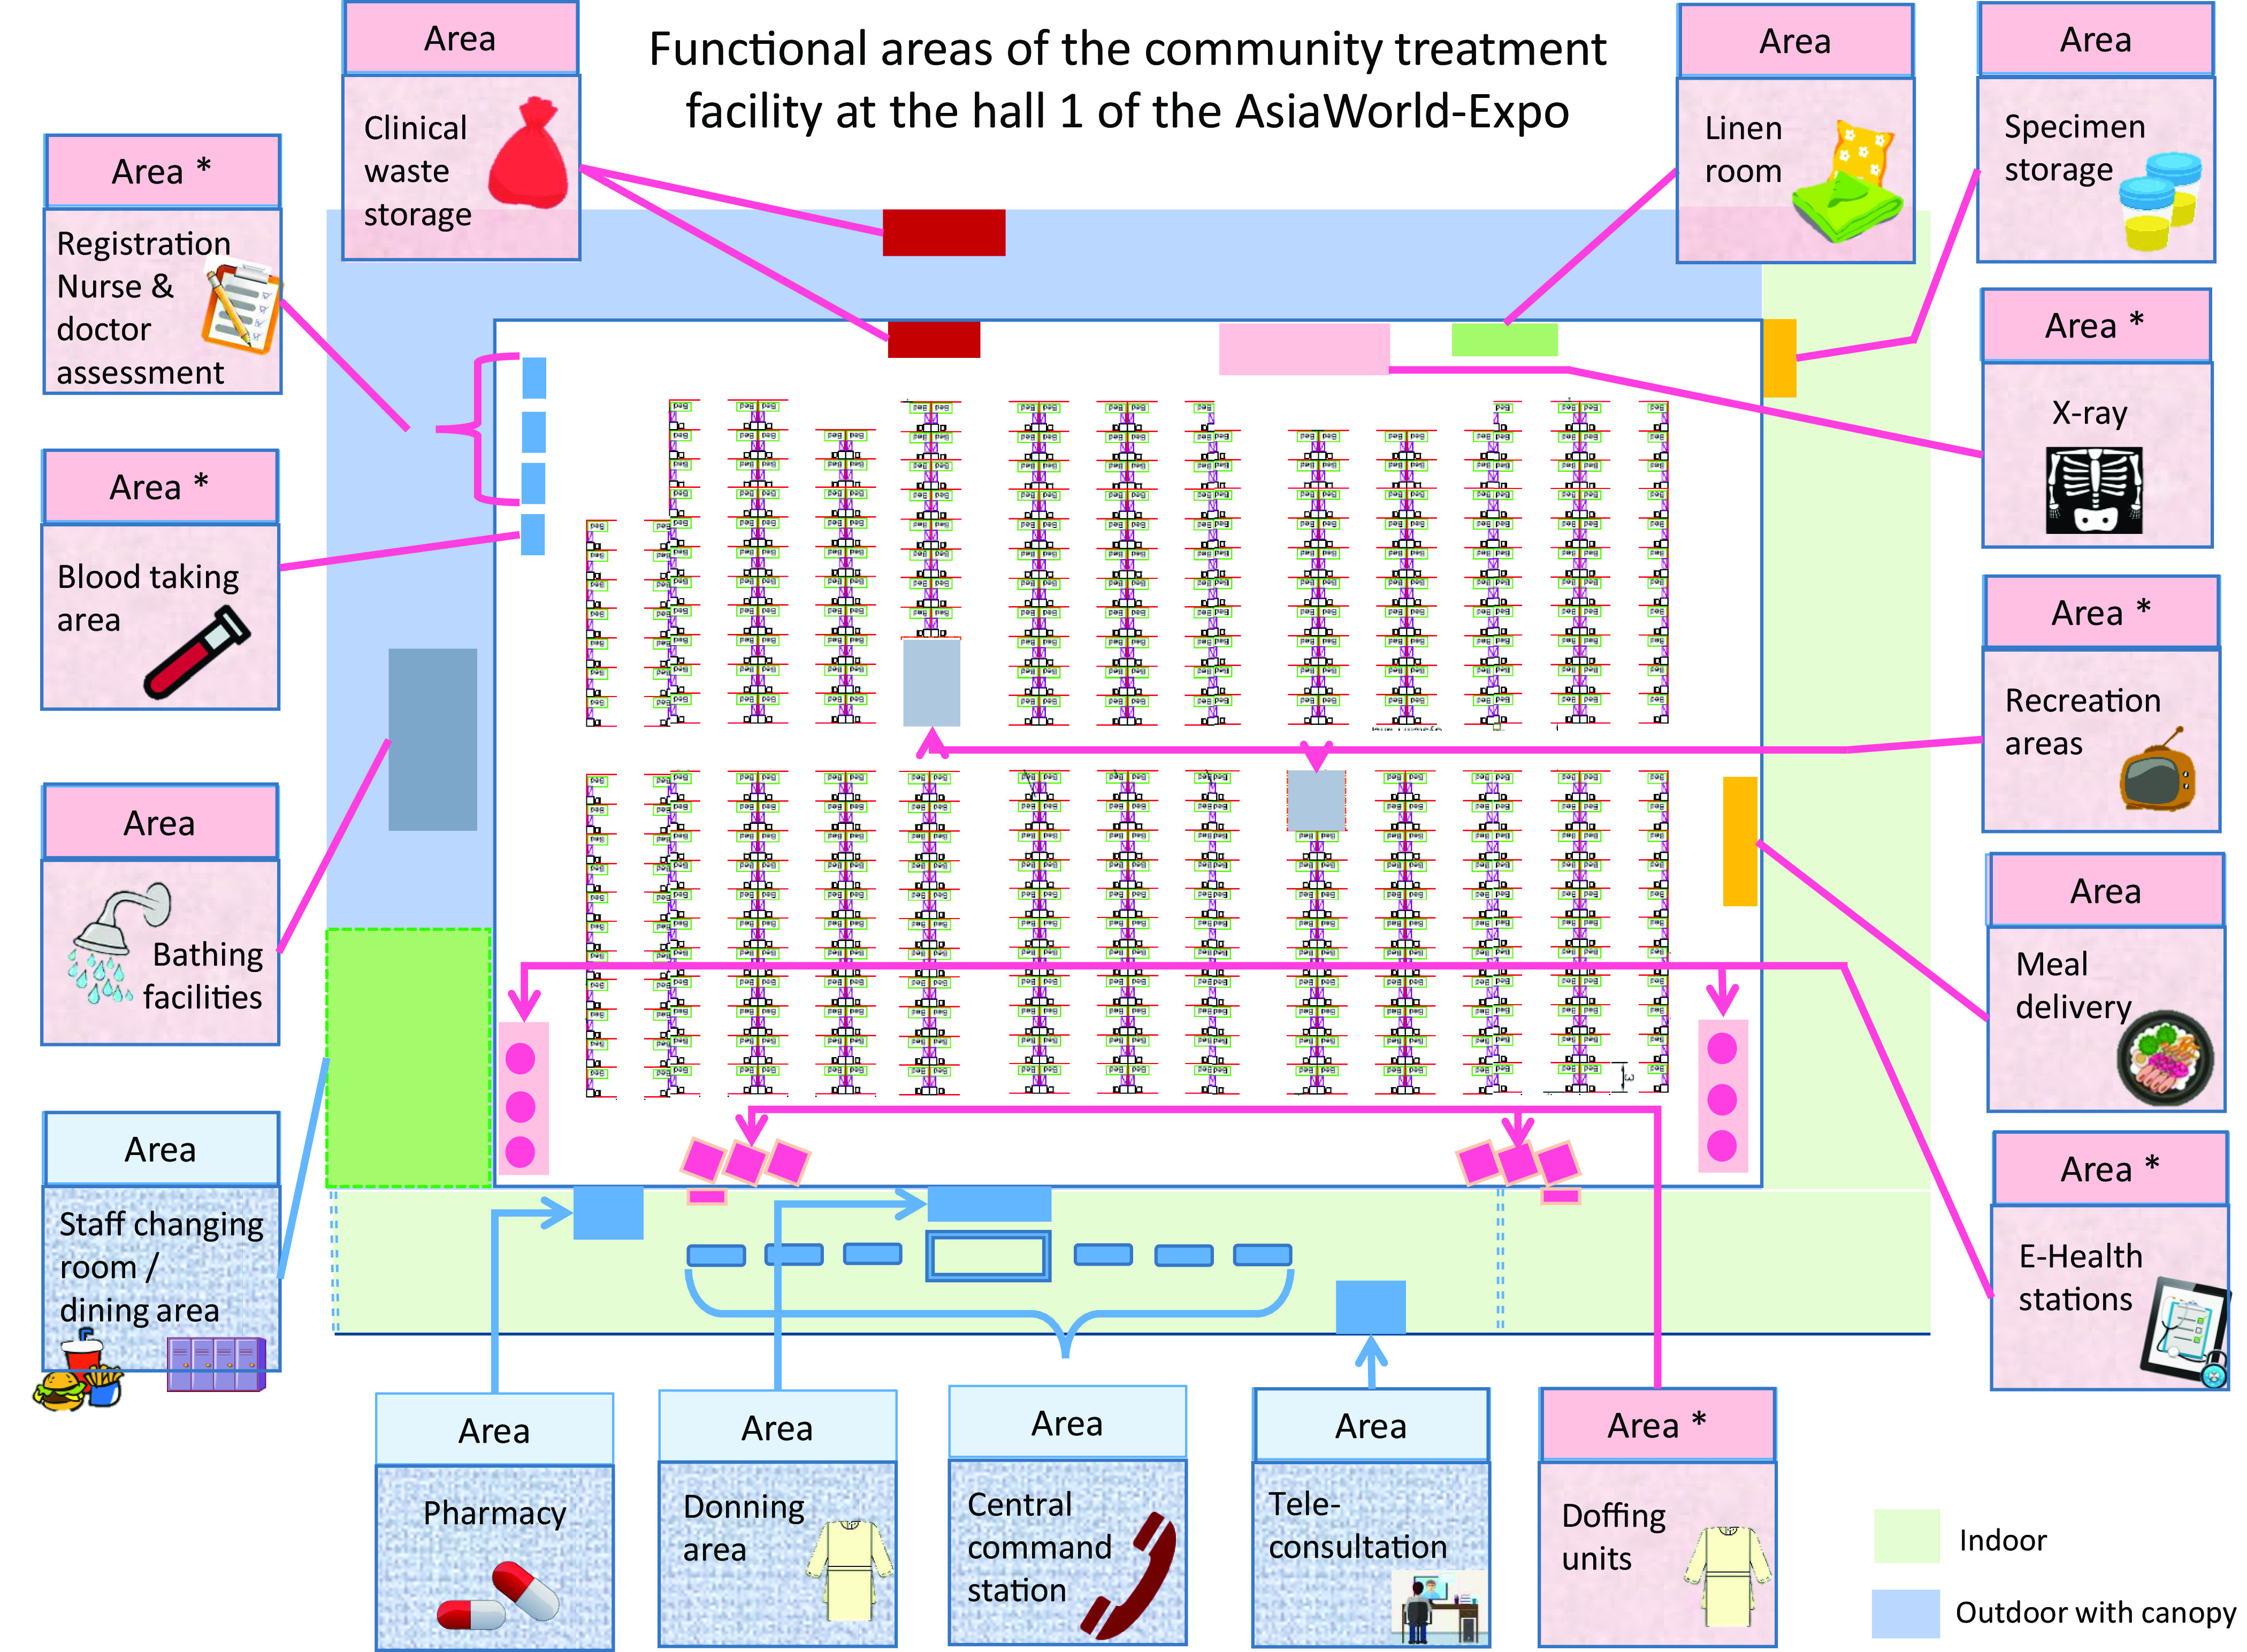
Functional areas of the community treatment facility (CTF) at the hall 1 of the AsiaWorld-Expo. Note. In the red zone, the functional areas marked with asterisk (*) represent the areas in frequent contact with either patients or healthcare workers. Environmental surface swabs were prospectively collected for 4 weeks to detect SARS-CoV-2 by RT-PCR. Air samples were collected at the registration area, 2 recreation areas, and at the bedsides of 3 patients with lowest, second lowest, and third lowest cycle threshold values of the deep throat saliva by RT-PCR on the day of sample collection. The registration area for nurse and doctor assessment, waiting area, blood taking area, radiograph area, E-health station, recreation area, and doffing area were disinfected manually by sodium hypochlorite solution (1,000 ppm) soaked in disposal wipe immediately after use under the scheme of directly observed environmental disinfection. If blood, secretions, vomitus, or excreta was spilled, the environmental surface was disinfected with sodium hypochlorite solution (10,000 ppm) soaked with a disposal wipe for 10 minutes before rinsing with water. Because the ventilation flow rate was 80 L per second per person and all patients wore surgical masks, it was not necessary to move the patients out during environmental disinfection.